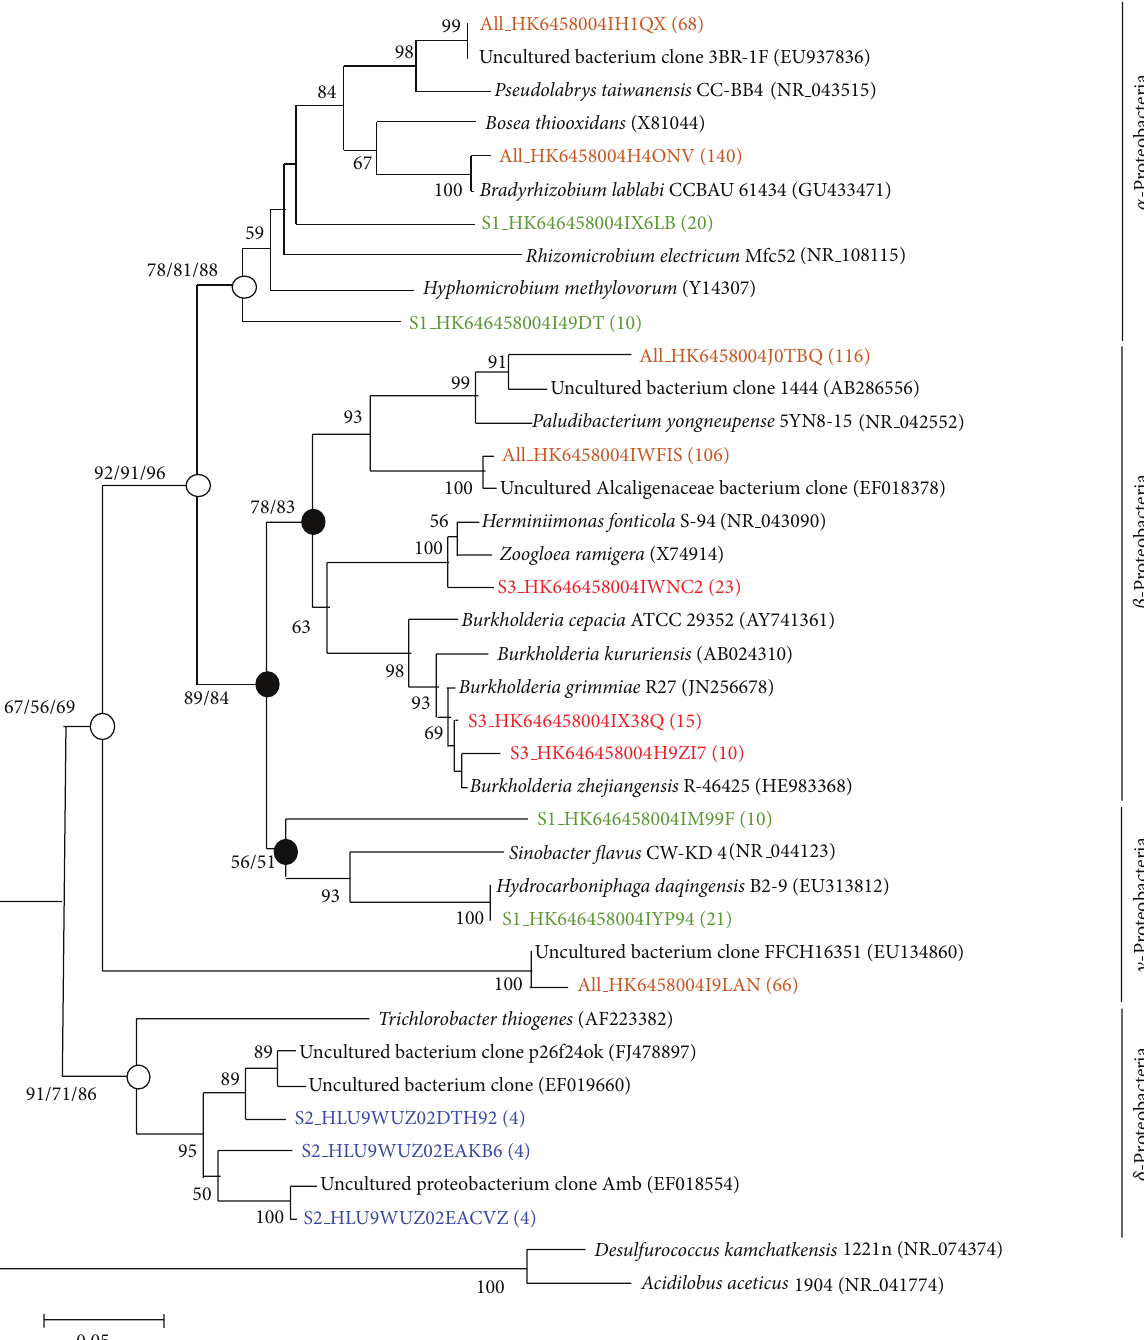
Figure 7: Neighbor-joining phylogenetic tree showing the dominant bacterial relationships associated with phylum Proteobacteria in the soil samples. The bar in the bottom represents 0.05 nucleotide substitutions per nucleotide